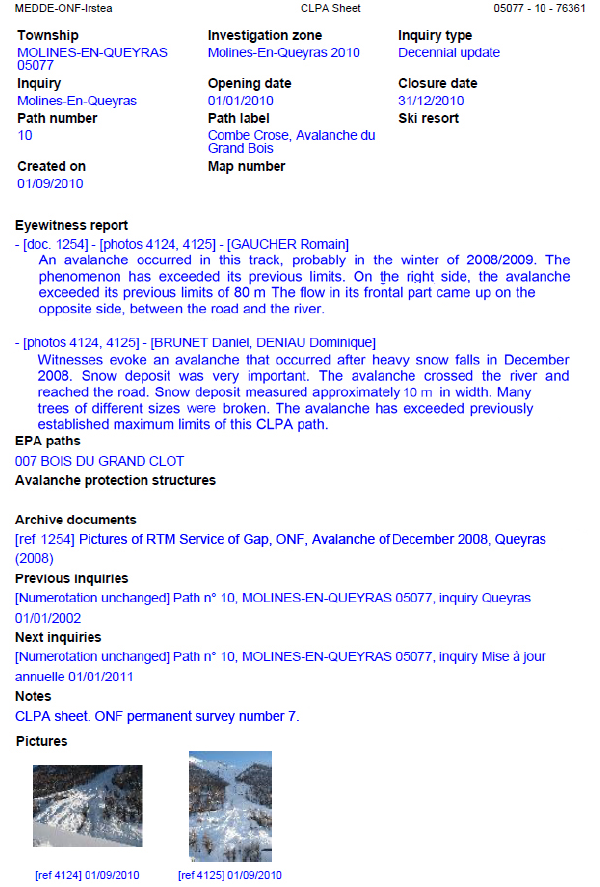
Figure 5. A CLPA sheet for the CLPA path number 10 in Molines- en-Queyras township. It contains eyewitness reports, archival doc- uments, photographs and other information obtained from this path during a CLPA inquiry. Eyewitness reports are currently available in French only. Based on this information, an observer decides if the existing contour of the path needs to be updated or not. If necessary, the observer draws a new contour (see Fig. 3).